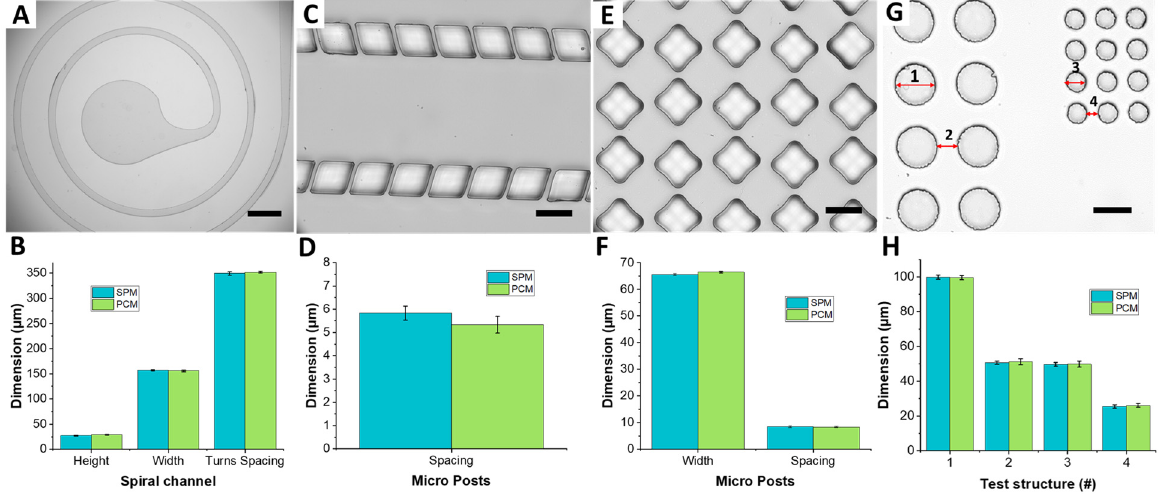
Figure 5. PDMS replicas formed from PC master of a microfluidic device having a spiral channel, micro post arrays having different spacing and shapes. ( A ) Top view image of the spiral channel covering an area of 30 mm 2 , channel cross section has a width of 150 µm and a height of 30 µm, and adjacent turns are spaced by 350 µm; scale bar is 500 µm. ( B ) Quantitative comparison of spiral channel height, width and spacing ( n = 5). ( C ) Two parallel post arrays spaced by 5 µm; scale bar is 50 µm and ( D ) quantitative comparison of post spacing ( n = 5). PC melt can flow in gaps as small as 5 µm during the heat molding process. ( E ) A matrix of staggered micro posts having minimum spacing of 8 µm; scale bar is 50 µm and ( F ) quantitative comparison of posts structures width and spacing ( n = 5). ( G ) Circular pillar arrays of diameter 100 µm (Test Structure 1) and 50 µm (Test Structure 2), separated by 50 µm (Test Structure 3) and 25 µm (Test Structure 4) gaps; scale bar is 100 µm and ( H ) Quantitative comparison of Test Structures ( n = 15).